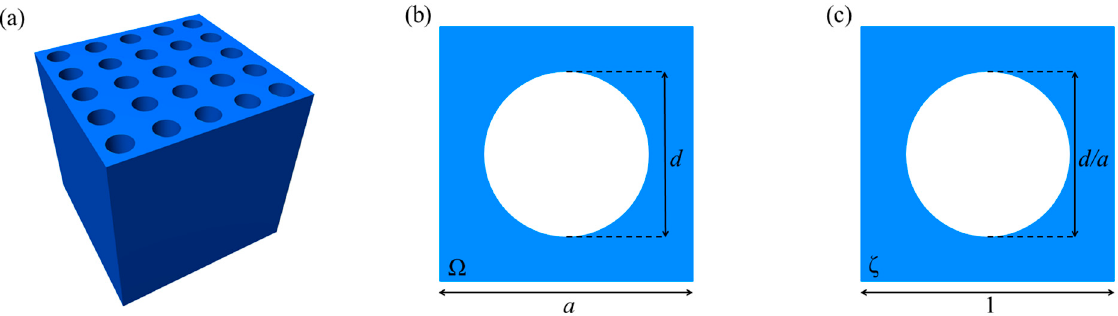
Figure 2. Model of a two-dimensional square-lattice phononic crystal: ( a ) three-dimensional physical model, ( b ) unit cell, and ( c ) unit cell, made dimensionless.